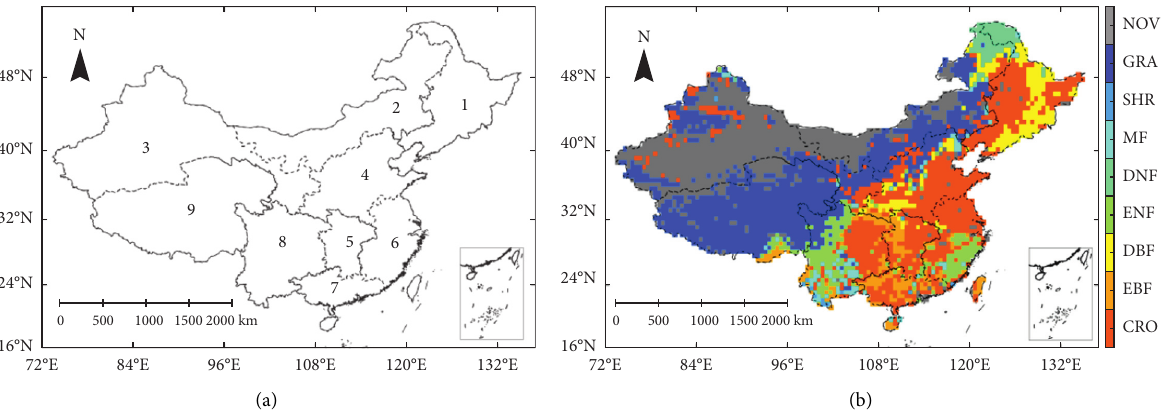
Figure 1: Study area covering (a) nine large subregions (1: Northeast China, 2: Inner Mongolia, 3: Northwest China, 4: North China, 5: Central China, 6: Southeast China, 7: South China, 8: Southwest China, and 9: Tibetan Plateau) with various vegetation types (CRO: croplands, EBF: evergreen broad-leaved forests, DBF: deciduous broad-leaved forests, ENF: evergreen needleleaf forests, DNF: deciduous needleleaf forests, MF: mixed forests, SHR: shrublands, GRA: grasslands, and NOV: non-vegetation